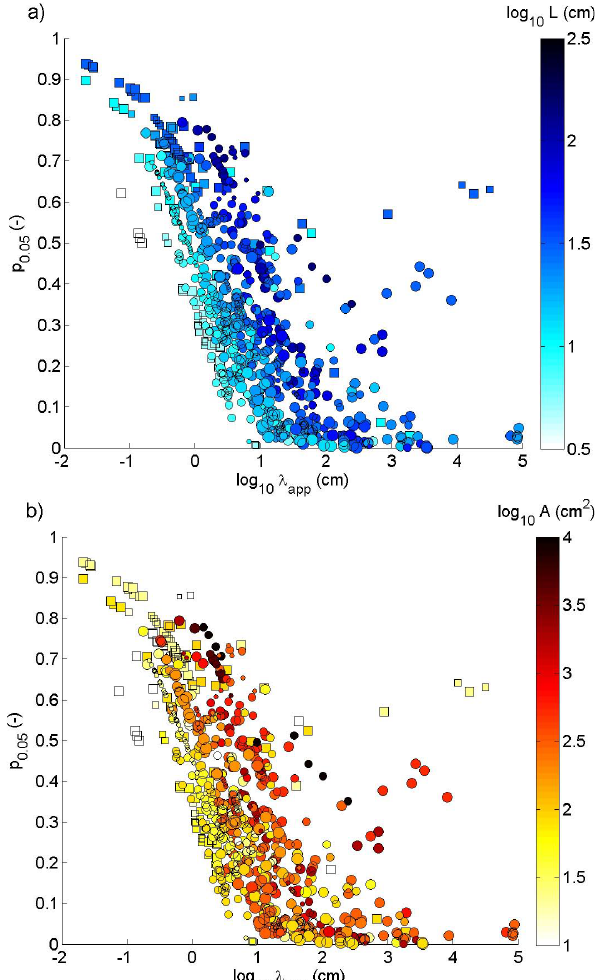
Fig. 5. Comparison of the apparent dispersivity, λ app , and normal- ized 5%-arrival time, p 0 . 05 , with (a) the travel distance, L , and (b) the area of the breakthrough plane, A . The symbol size corre- sponds to the water fluxes, q, under which the respective experiment was conducted, small symbols indicating small water fluxes, large symbols denoting large water fluxes. The meaning of the symbol shape is explained in Fig.